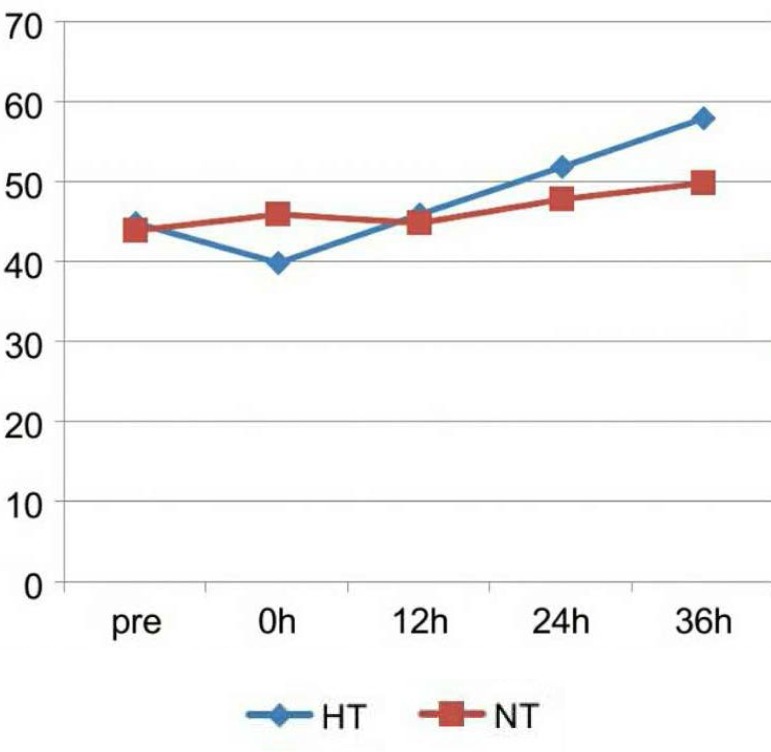
Mean arterial pressure (MAP) changes of the two groups. The MAP of the HT
is significantly lower than the NT at 0 hour, because we used the
sedation and neuromuscular blockade. But the MAP of the HT is
significantly higher than the NT after hypothermia at the
36th hour (P<0.05).